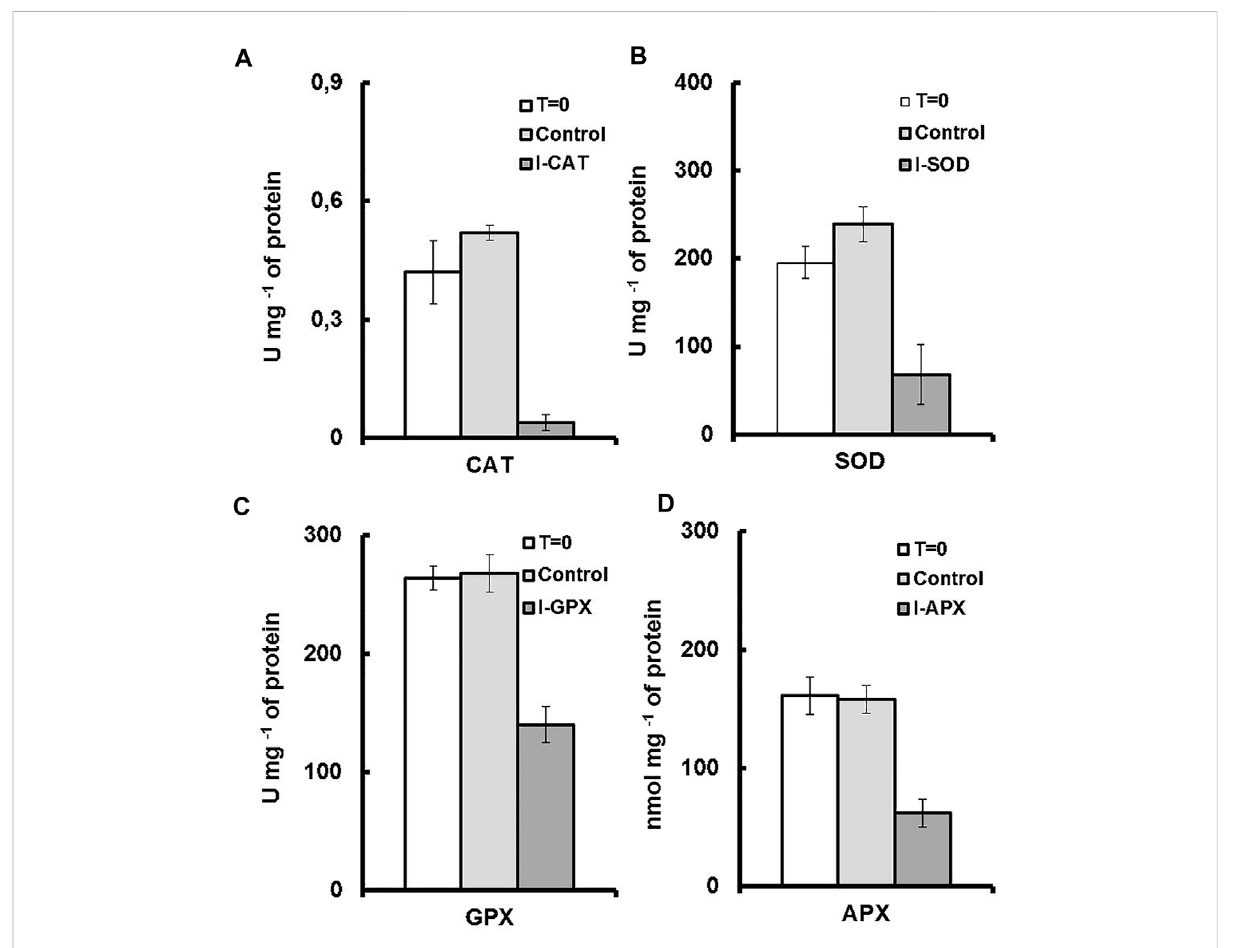
FIGURE 4 Enzymeactivitiesforeachculturemedium.T=0representstheenzymeactivityoninoculation.Controlrepresentstheenzymaticactivityofthe control culture on termination. I-enzyme, represents the enzymatic activity of the culture on termination. (A) is CAT activity. (B) is SOD activity. (C) is GPX activity (D) is APX